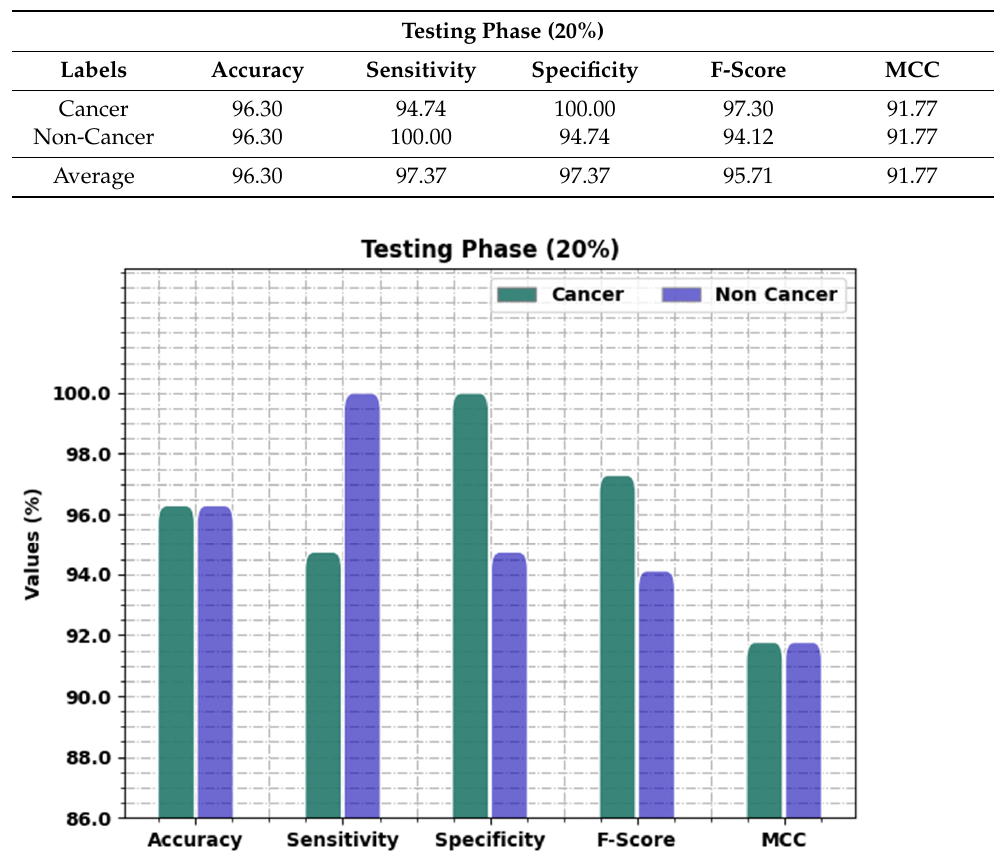
Figure 4. Result analysis of OIDCNN-OPMDD approach under 80% of TR data. Table 3. Result analysis of OIDCNN-OPMDD approach with distinct class labels under 20% of TS data.